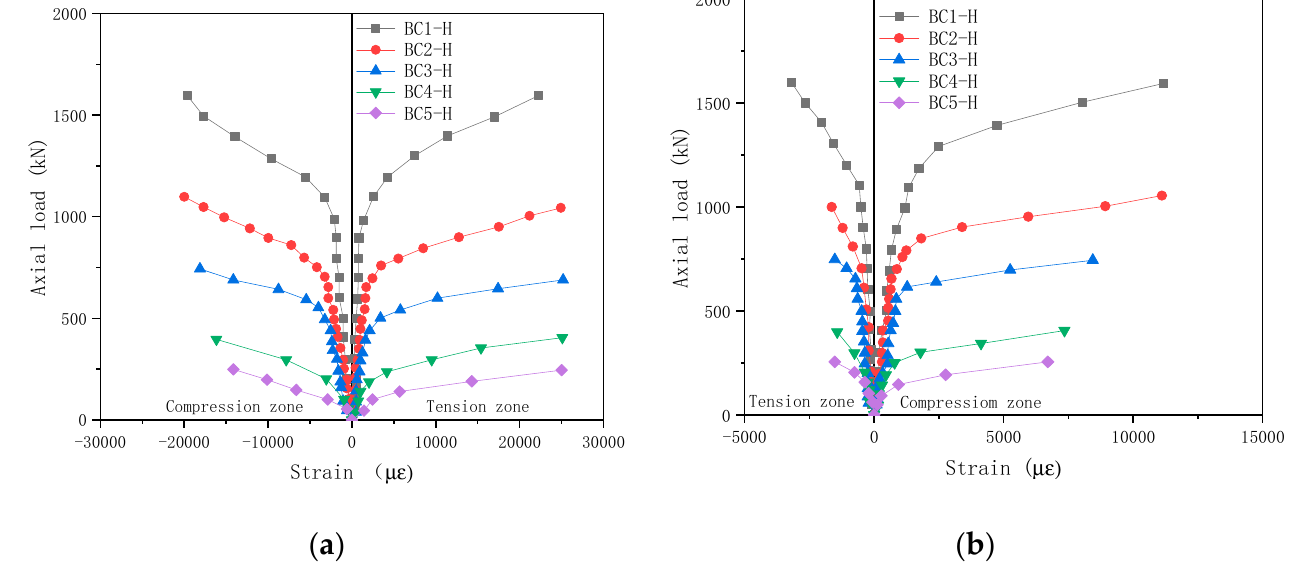
Figure 10. Axial load–strain relationship curves for CFGT columns with eccentric loads ( a , b ).